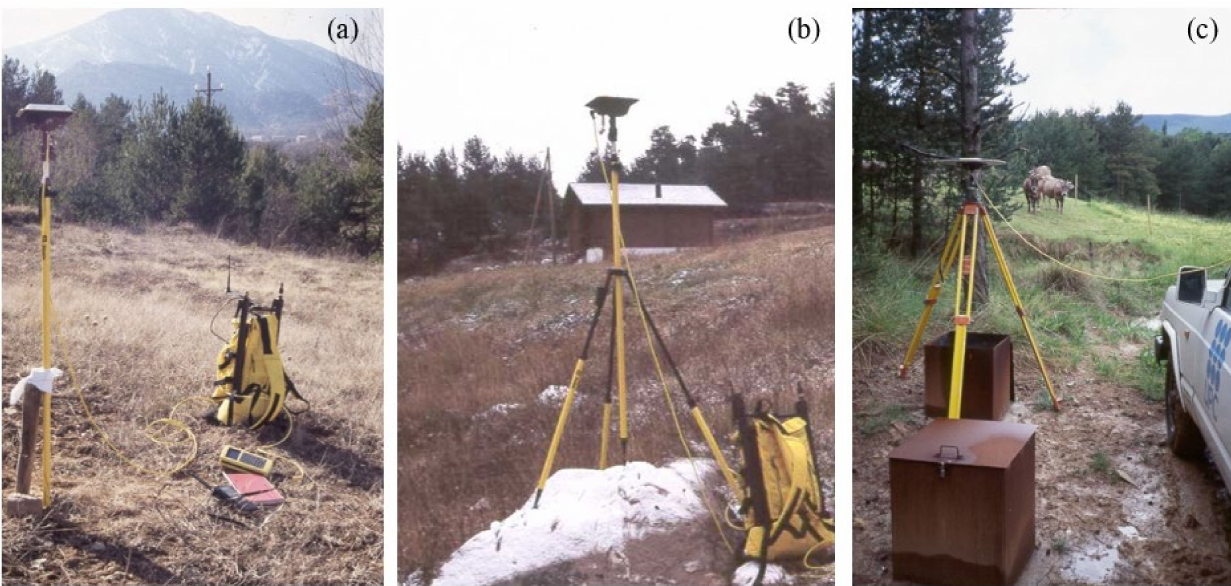
Figure 8. Examples of Vallcebre monitoring points with different antenna setup: telescopic pole ( a ); pole with mini-tripod ( b ); ground-plane antenna over a tripod, centered with an optical plummet over an inclinometer borehole ( c